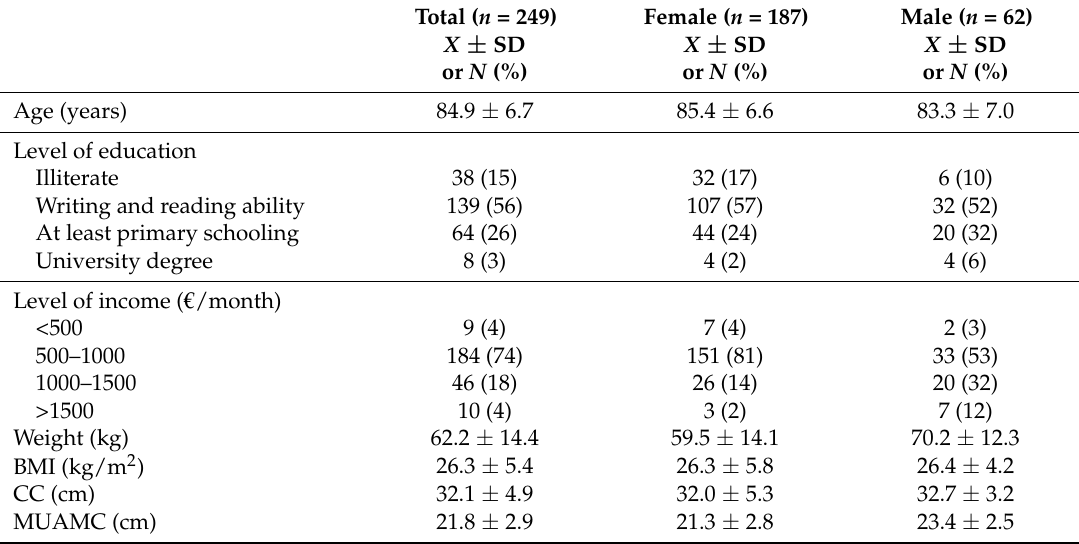
Table 1. Characteristics of the long-term care home